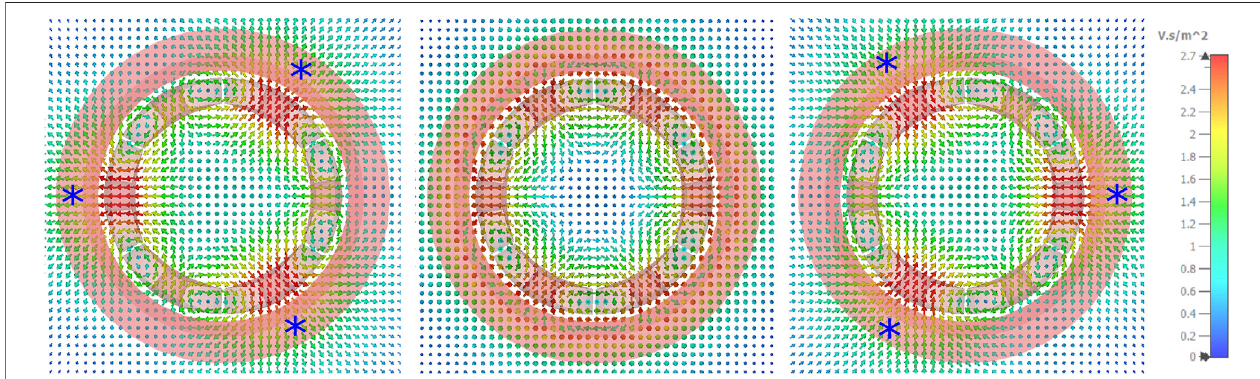
FIGURE 6 | From left to right, | B | vector plot along the xy plane at the positions z = − 100, 0, 100 mm. The magnetic branches positions are indicated by a blue marker.